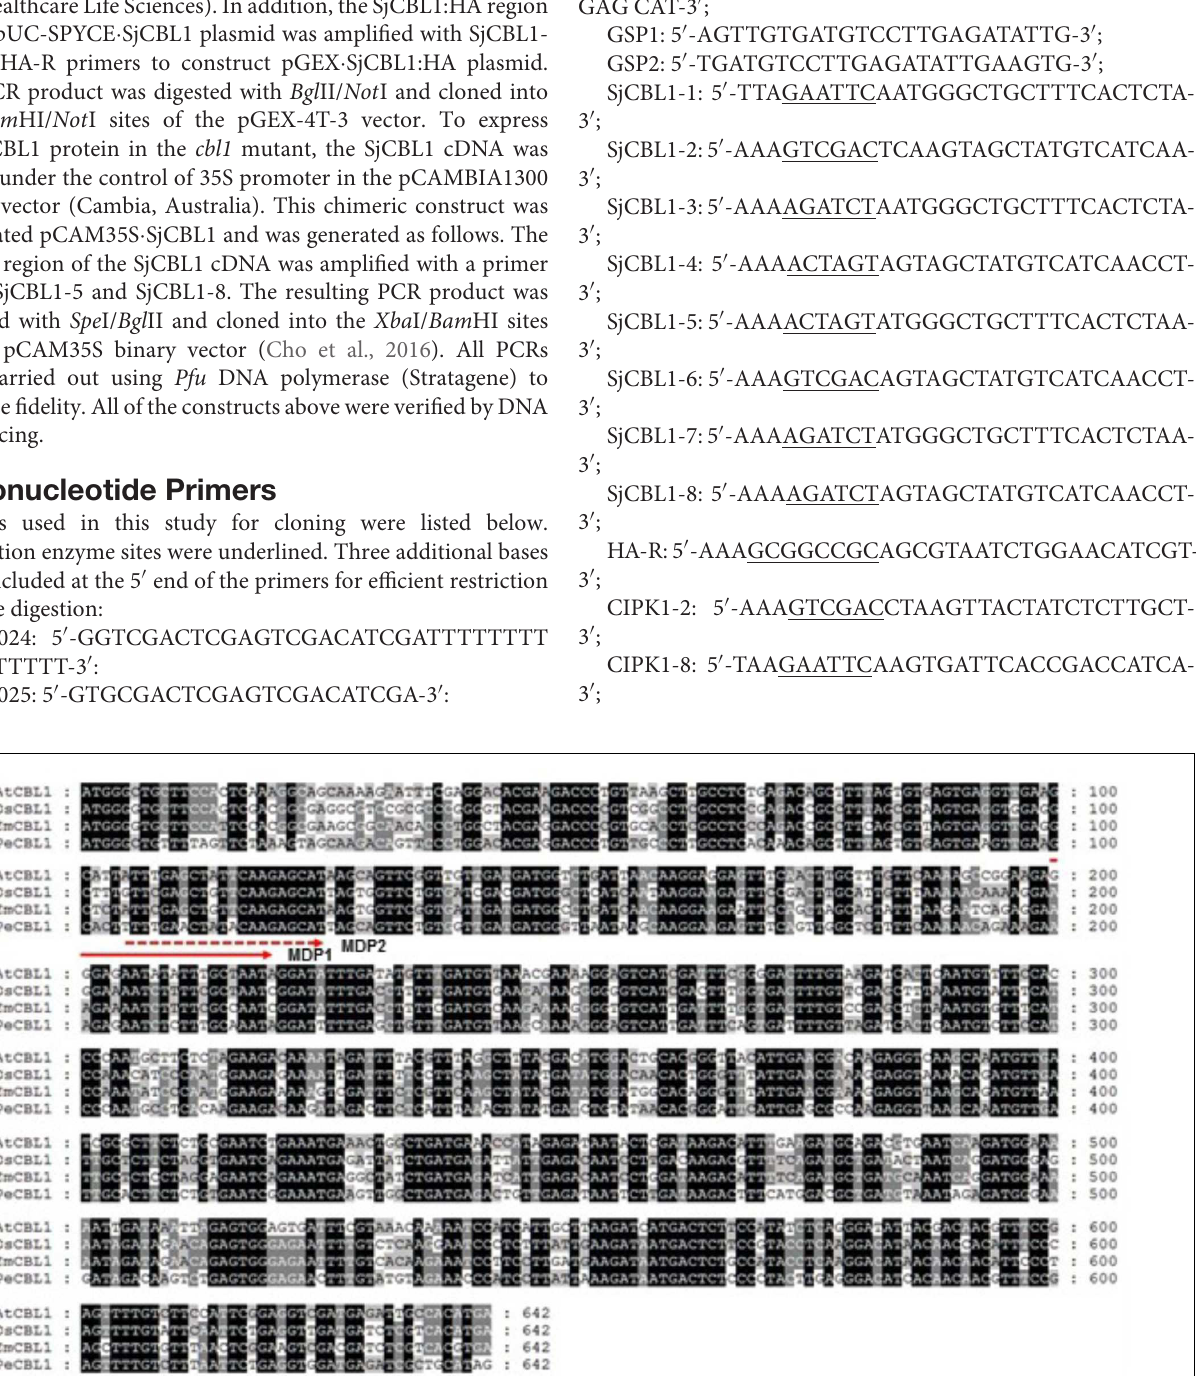
Frontiers in Plant Science |